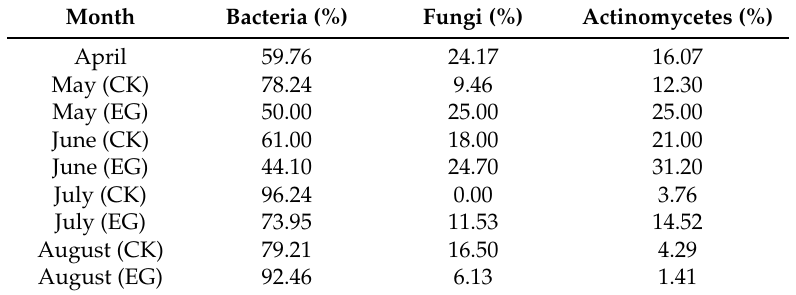
Table 2. Percentage of bacteria, fungi, and actinomycetes counts in kiwifruit planting soil. Month Bacteria (%) Fungi (%) Actinomycetes (%) April 59.76 24.17 16.07 May (CK) 78.24 9.46 12.30 May (EG) 50.00 25.00 25.00 June (CK) 61.00 18.00 21.00 June (EG) 44.10 24.70 31.20 July (CK) 96.24 0.00 3.76 July (EG) 73.95 11.53 14.52 August (CK) 79.21 16.50 4.29 August (EG) 92.46 6.13 1.41 CK: control group; EG: experimental